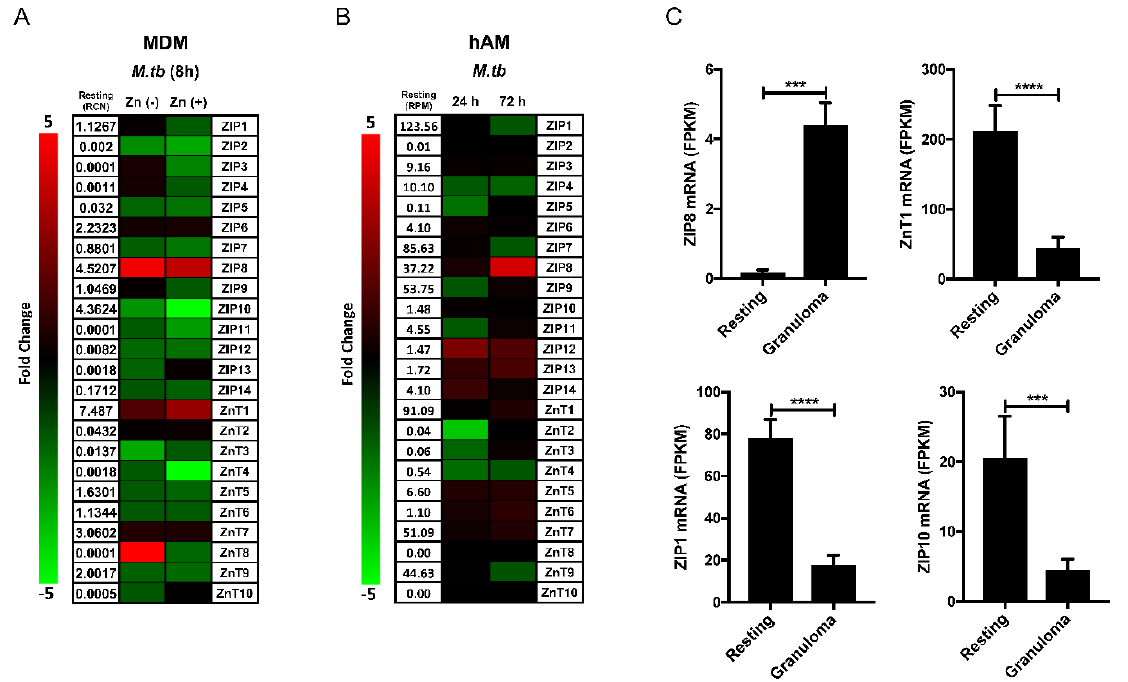
Figure 1. Macrophage zinc transporter mRNA expression during M.tb infection. Zrt-Irt-like-Protein (ZIP) and zinc transport protein (ZnT) mRNA expression is altered by infection with Mycobacterium tuberculosis ( M.tb ) H 37 R v using a multiplicity of infection (MOI) of 5:1 for ( A ) 8 h in monocyte-derived macrophages (MDMs) in the absence or presence of ZnSO 4 18 µ M, as determined by qRT-PCR relative to GAPDH ( n = 3) or ( B ) for 24 or 72 h in human alveolar macrophages (hAMs) infected by M.tb H 37 R v , as determined by AmpliSeq Transcriptome analysis ( n = 6). ( C ) The mRNA expression of ZIP8 is increased and ZnT1, ZIP1, and ZIP10 are decreased in M.marinum -infected zebrafish granulomas compared to resting macrophages, as determined by RNA-Seq. (A and B are unpublished data; C was generated using supplementary data published in Cronan et al. [53]) (mean ± SEM; *** p < 0.001; **** p < 0.0001; Prism-7: one-tailed Students t -test). MDM [54] and hAM [55] isolation, culture, and infection with M.tb , as well as the assay of human zinc transporters by qRT-PCR in MDMs [56] and AmpliSeq Transcriptome analysis in hAMs [52], were performed as previously